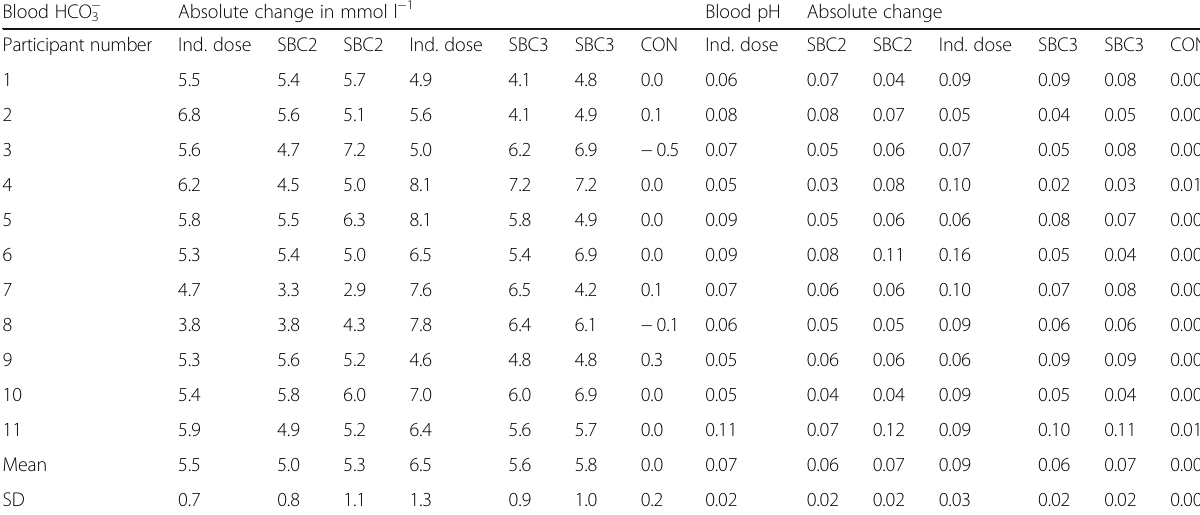
Table 3 Individual blood responses for both blood pH and bicarbonate (HCO 3 − ) following sodium bicarbonate (NaHCO 3 ) Blood HCO 3